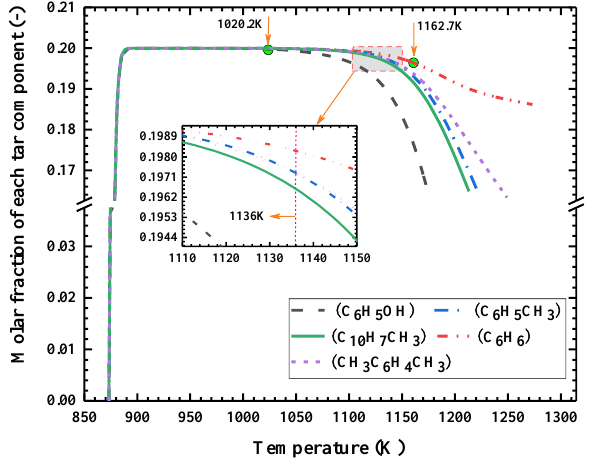
Figure 1. Variation of gas-phase tar with temperature without introduced Brown’s gas.